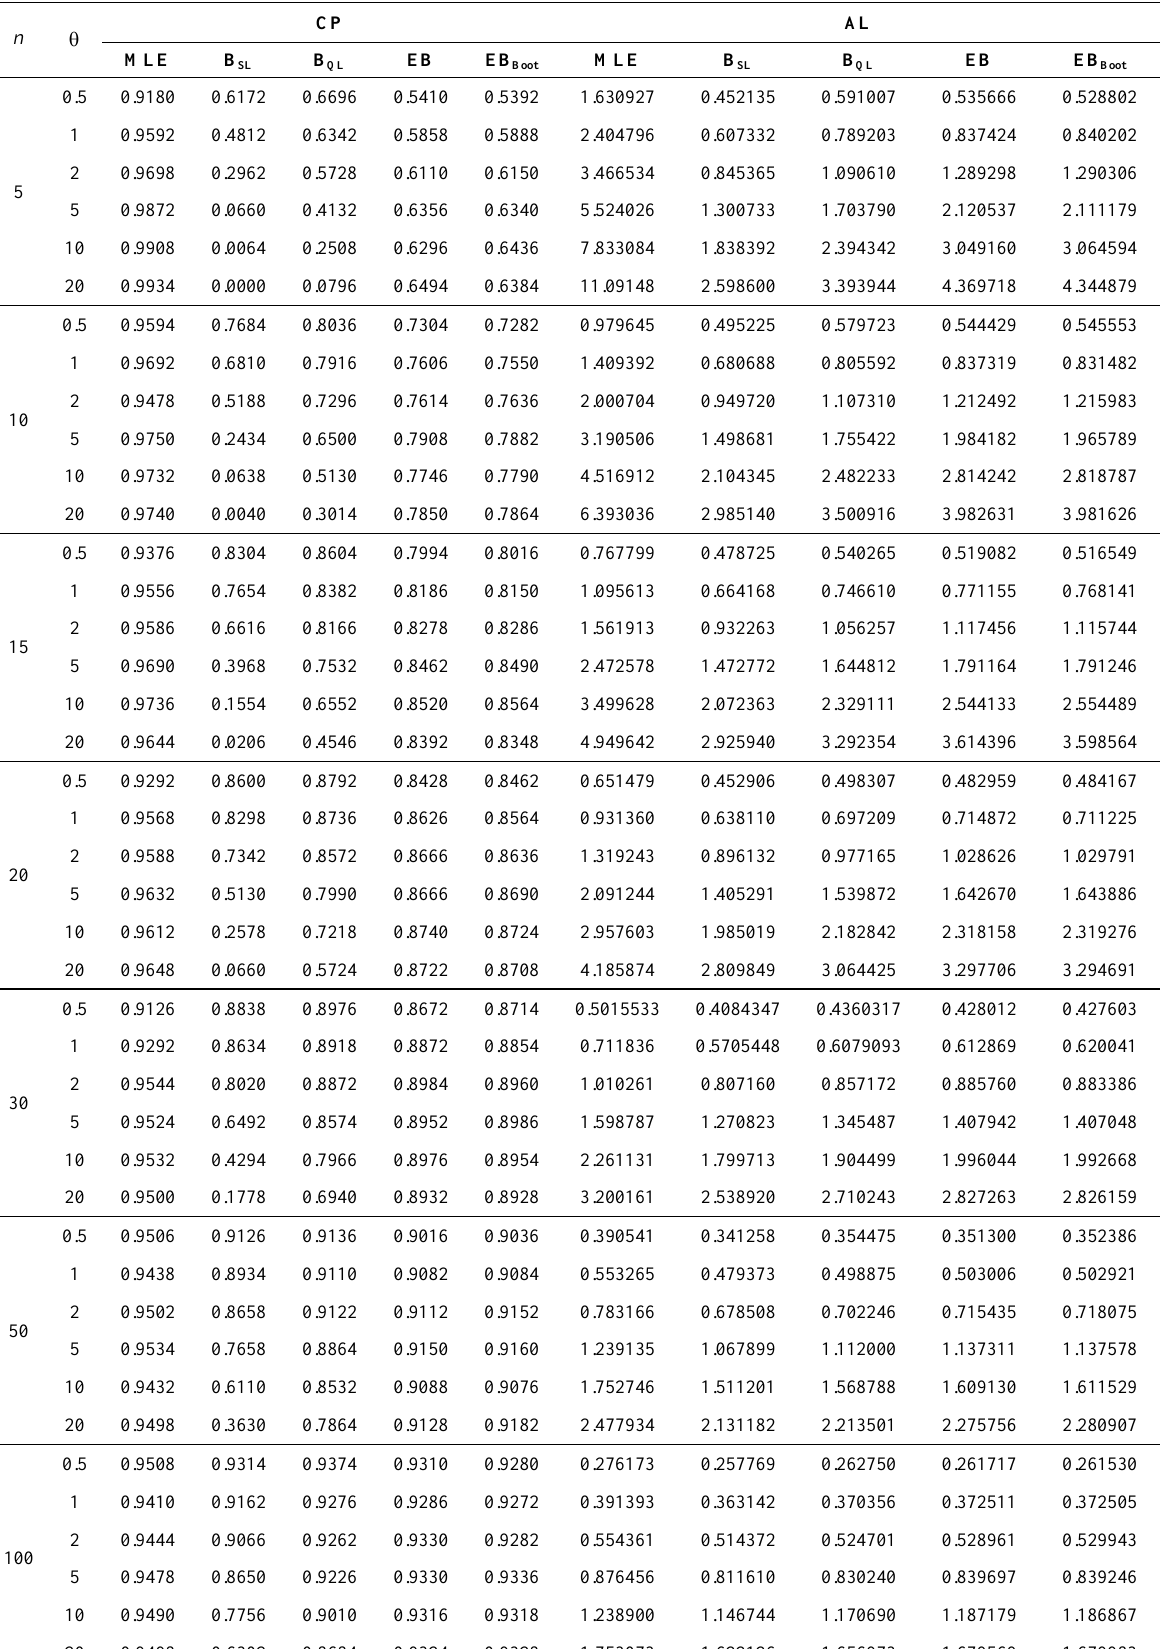
Table 7. Coverage probability (CP) and average length (AL) of 95% of confidence interval for the mean of Poisson